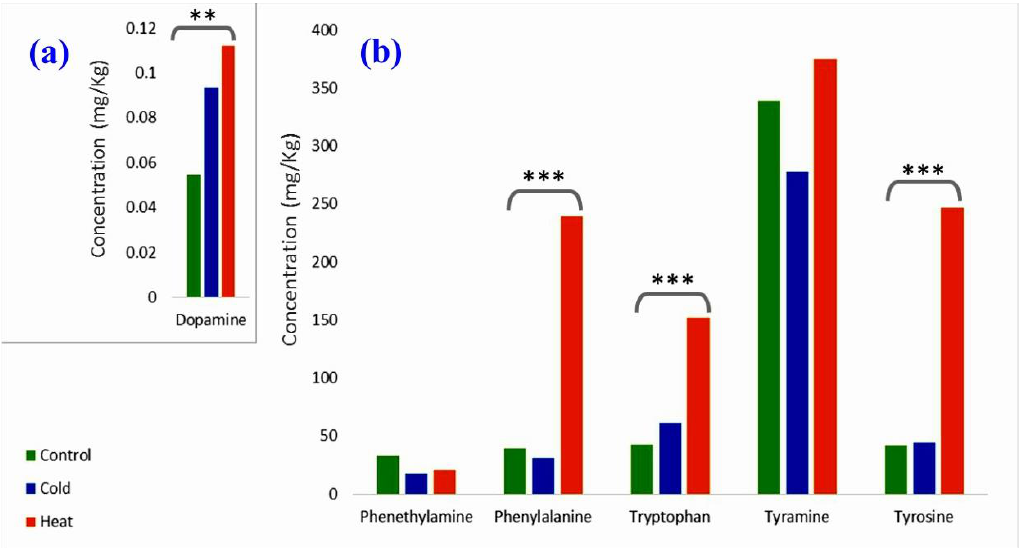
Figure 6. Bar chart of the average concentrations of the quantified amines in P. lentiscus plants grown under different temperature conditions. Control group is presented with green bars (control), low temperature plants with blue bars (cold), and high temperature plants with red bars (heat). ( a ) Rep- resentation of the low-concentration amines (dopamine). ( b ) Representation of high-concentration amines/amino acids (phenylethylamine, phenylalanine, tyrosine, tryptophan, tyramine). Results are expressed in mg/kg of dried leaves. ** ( p ≤ 0.05 ) and *** ( p ≤ 0.001 ).